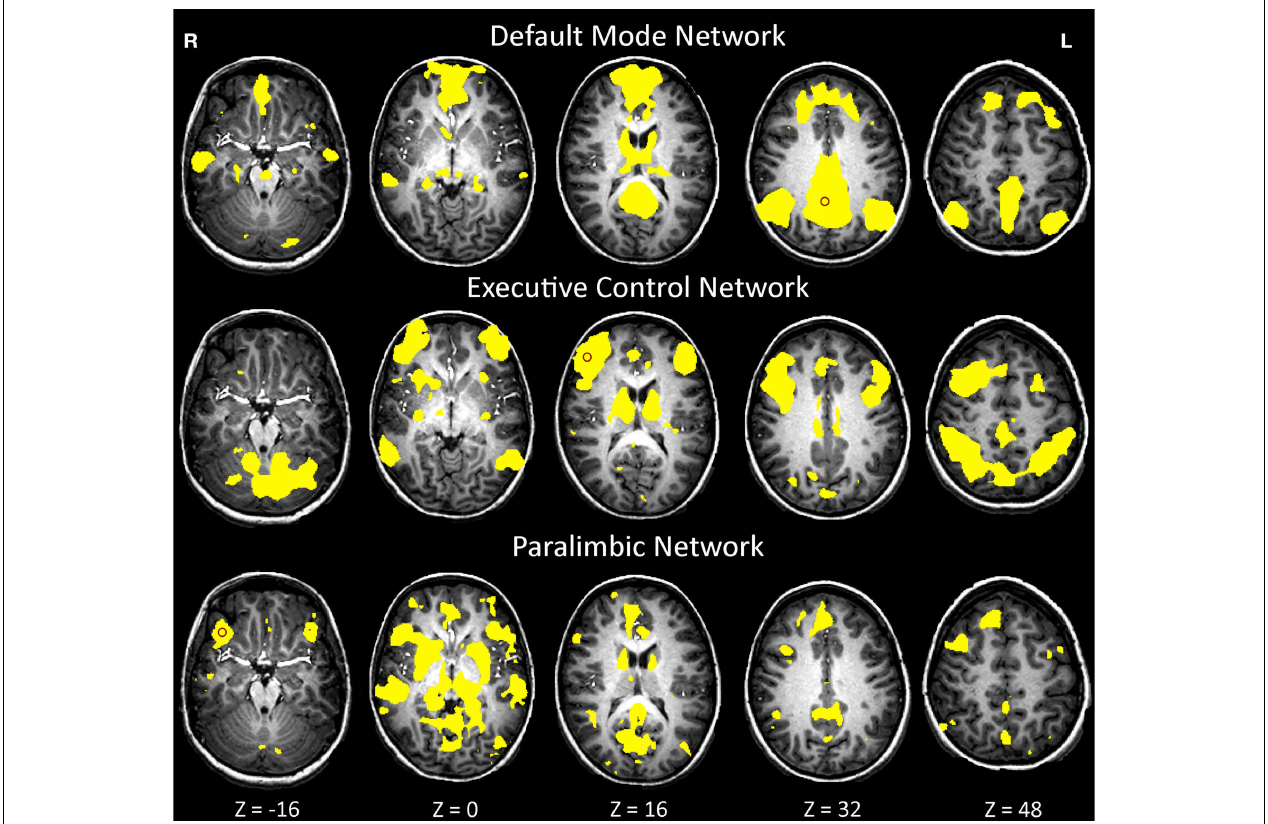
FIGURE 1 | Map of neural connectivity for the three major resting-state networks across all subjects ( n = 38). p < 0.0001. Red circles denote approximate locations of seed-point